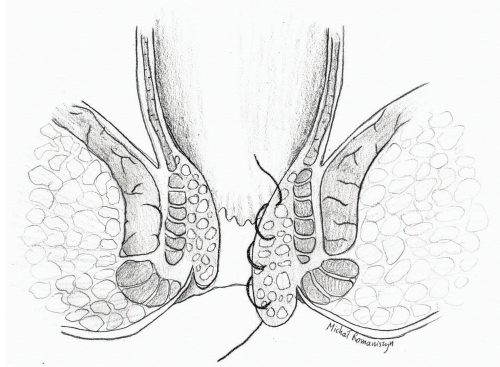
Figure 3: Longitudinal suture, covering the whole mass of a prolapsed haemorrhoid.